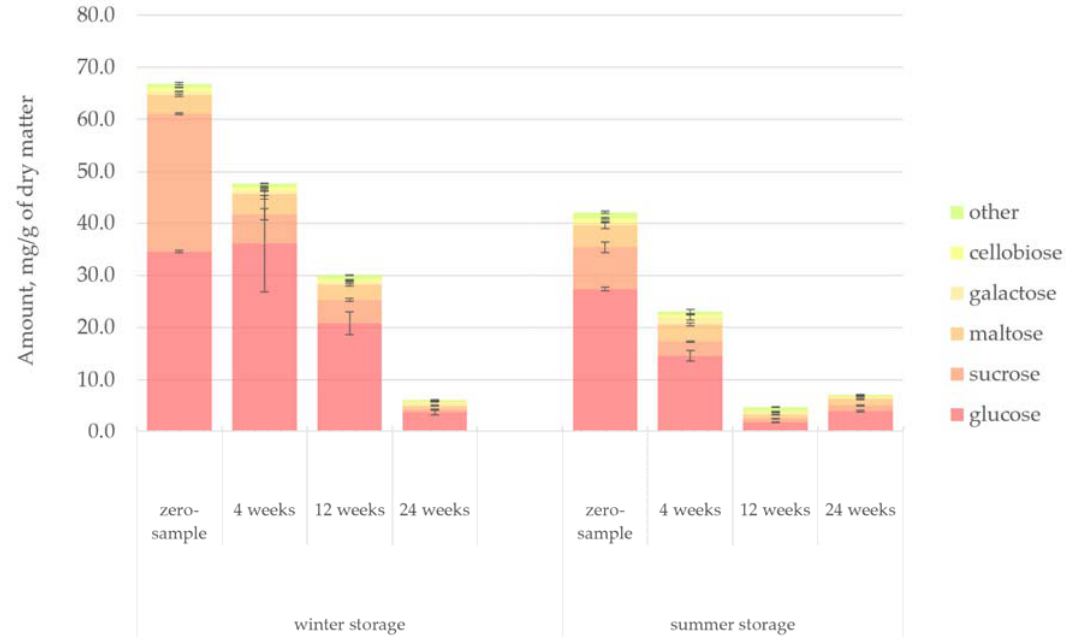
Figure 11. Changes in sugars during summer and winter storage periods of saw log bark.